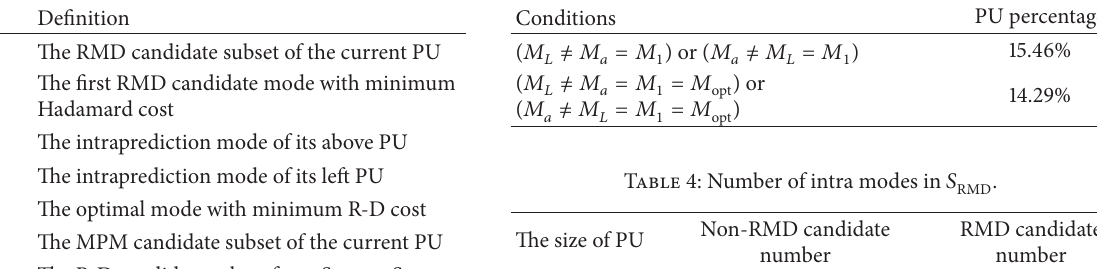
Table 3: The conditional probability of Experiment 2.